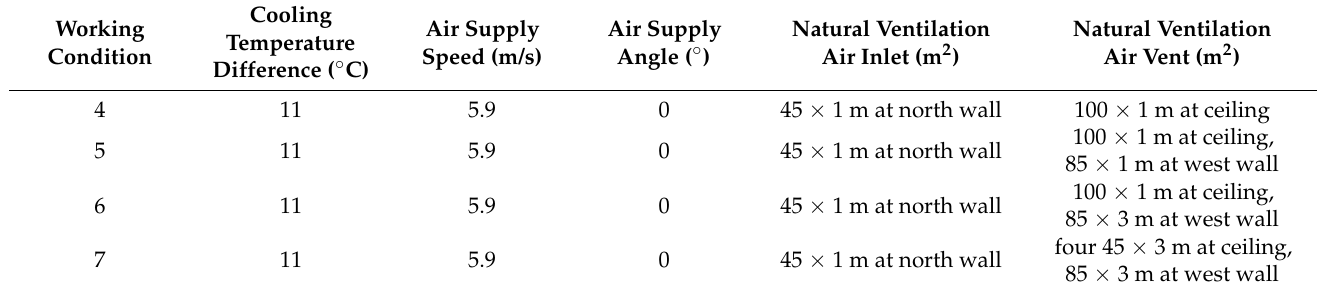
Figure 8. Working Condition 7 layout of natural vents. Table 8. Different working condition